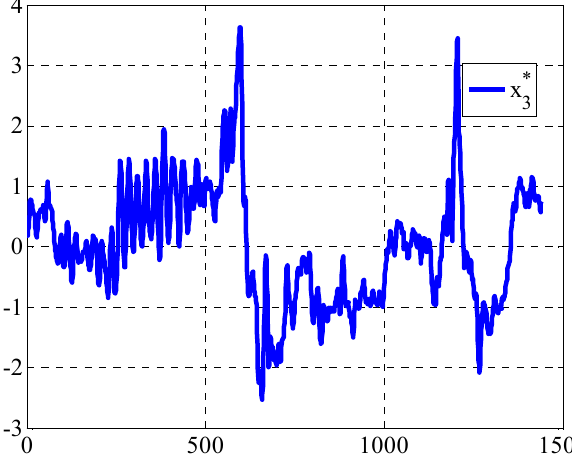
Figure 22. The standardized variable x ∗